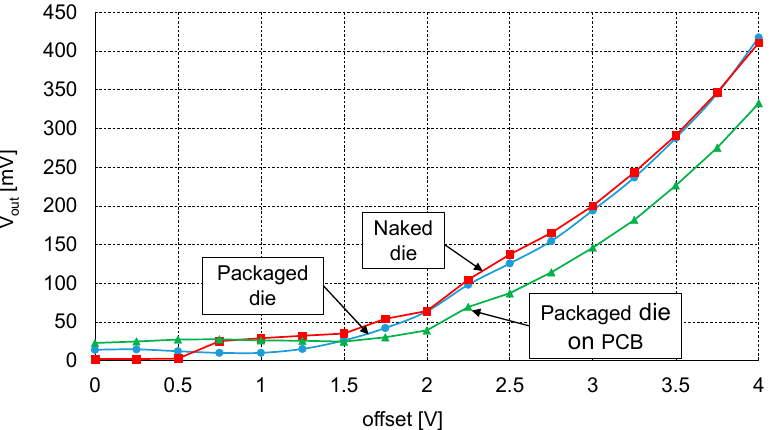
Figure 14. Comparison of results for three sets of measurements (for the naked die, for the packaged die and for the packaged die mounted on the PCB).